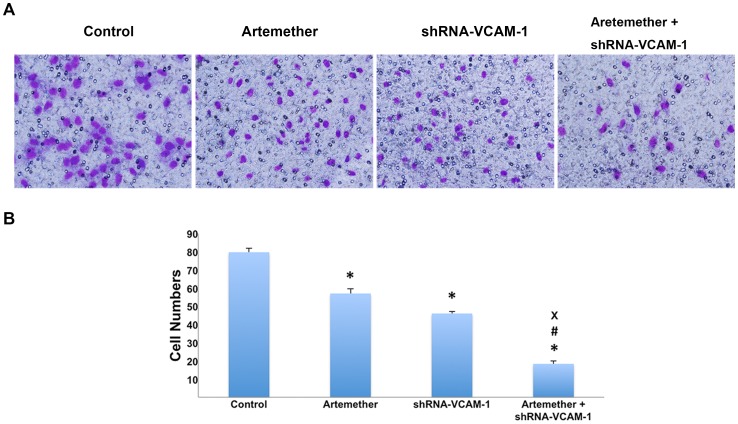
The effects of shRNA-VCAM-1 alone or combined with artemether on the invasiveness of U87 cells.(A) U87 cells were treated with artemether of 300 µmol/L, shRNA transfected or treated with both. Serum free L-DMEM served as a negative control. Cells migrating to the underside surface of Transwell filter were stained with Giemsa staining and photomicrographed, representing the invasiveness ability of U87 cells. (×400). (B) Statistical analysis of invasive cell numbers. The invasiveness of shRNA-VCAM-1 U87 cells was inhibited significantly compared with control group and the artemether+shRNA-VCAM-1 group displayed the maximum inhibitory effects. n = 4. *P<0.01 (compared with the control group); #
P<0.01, (compared with artemether group); ×
P<0.01 (compared with shRNA-VCAM-1 group).